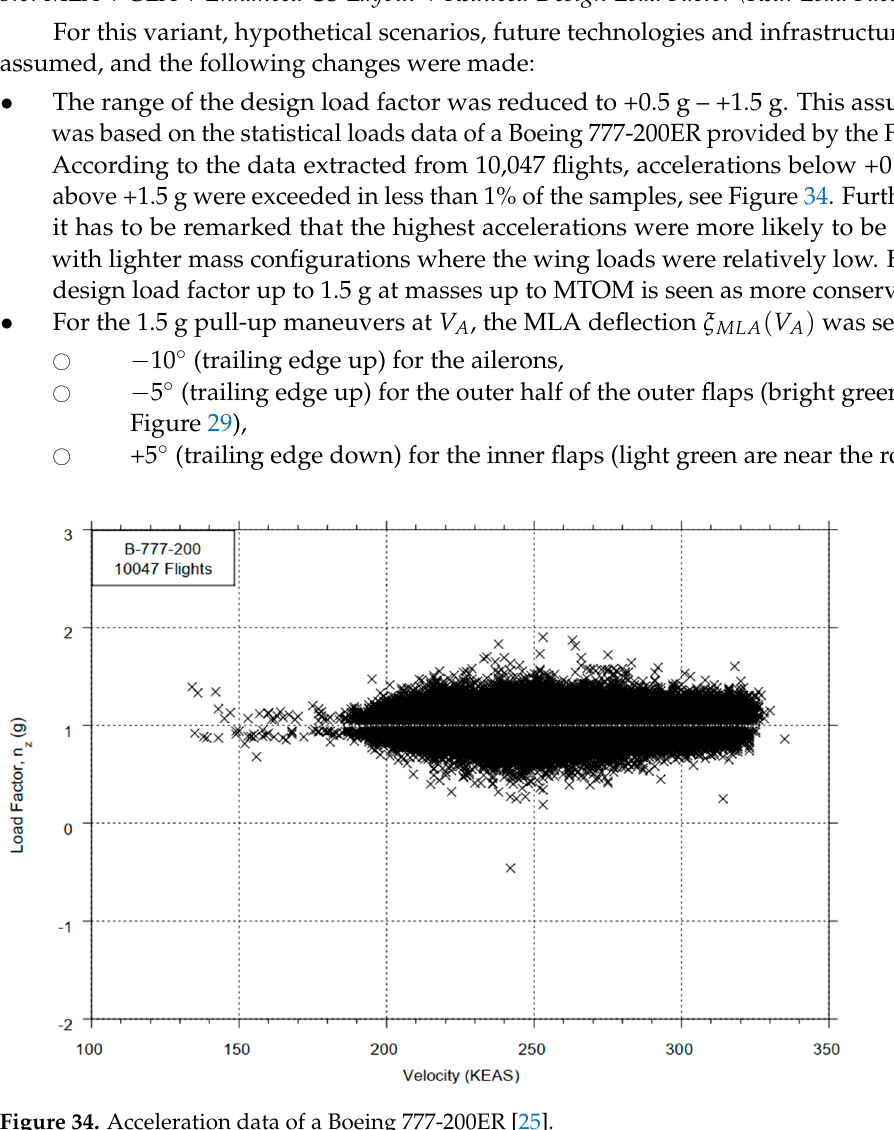
Figure 33. Material thickness distribution in m—enhanced MLA + GLA.